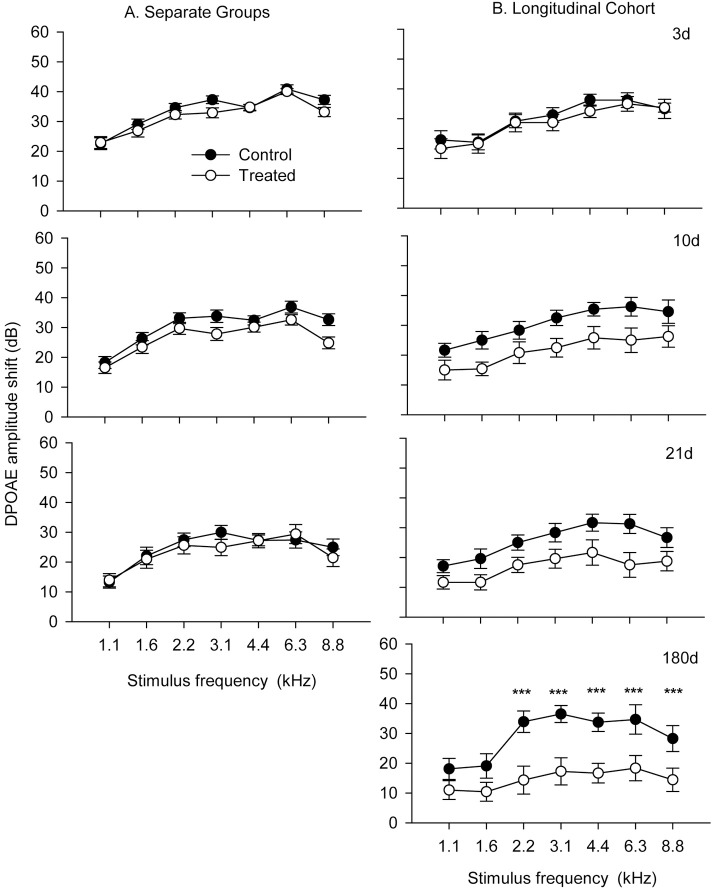
Distortion-product otoacoustic emission (DPOAE) amplitude shifts plotted in the same format as Fig 1.The number of ears at each time point is the same as ABR data. The symbols with vertical bars represent the means and SEM, respectively of DPOAE amplitude shifts at individual stimulus frequencies. Two-way ANOVA and Bonferroni Post Hoc test were applied. The symbols of *** indicate significance levels of p < 0.001.